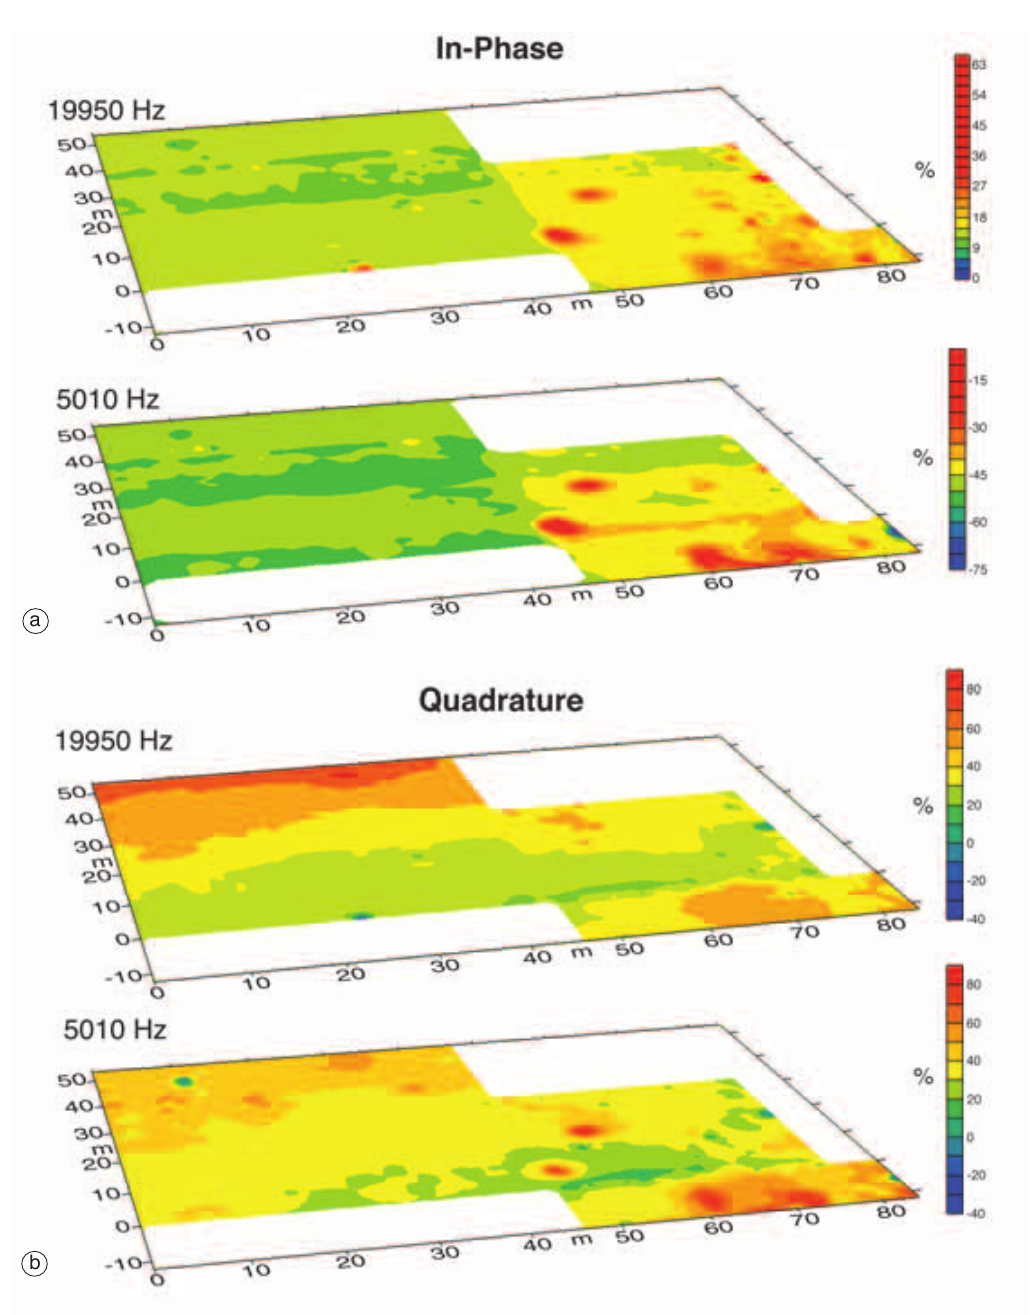
a Fig. 5a,b. The in-phase (a) and quadrature (b) component anomaly maps at 19950 and 5010 Hz (expressed as a percentage intensity of the signal).